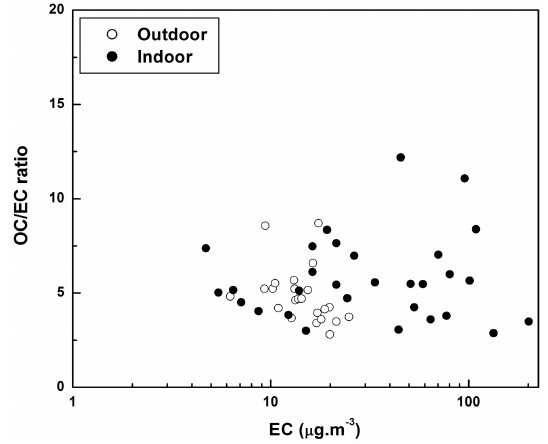
Fig. 7. Comparison between OC/EC ratio vs. EC concentration for Figure 7 3 indoor (SVI 1 village kitchen) and outdoor (SVI 1 village center)